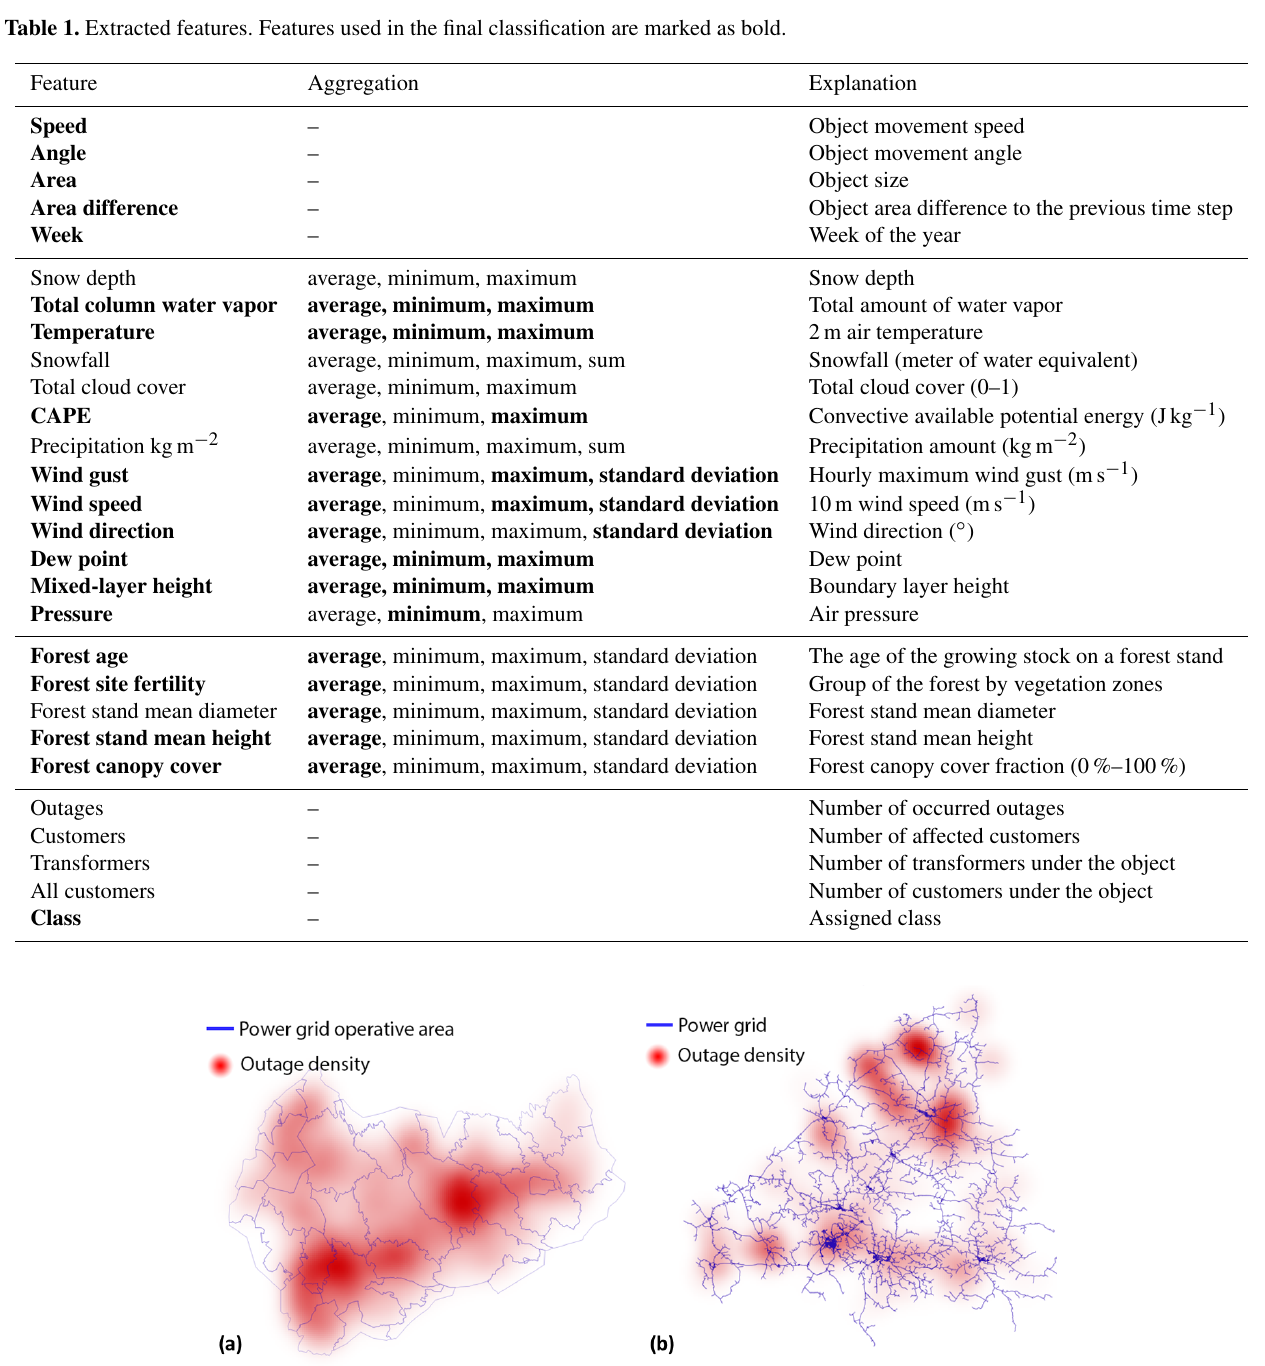
Figure 2. Spatial distribution of the outages between 2010 and 2018 visualized as a spatial heat map. (a) JSE network (southern area) and (b) Loiste network (northern